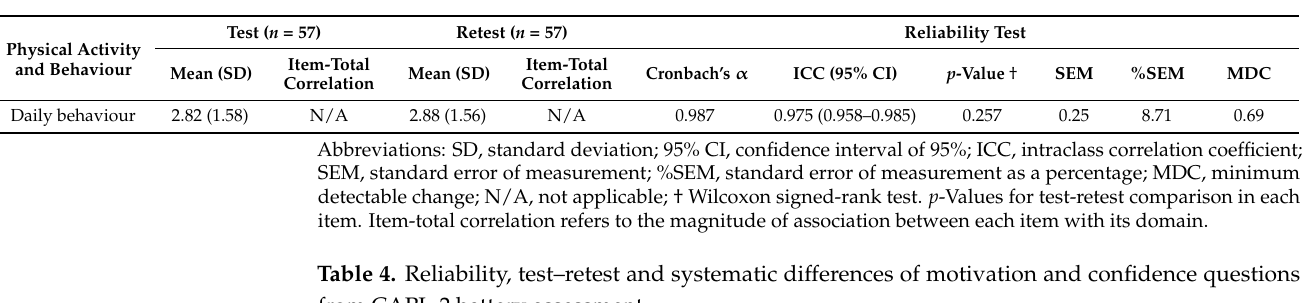
Table 3. Reliability, test–retest and systematic differences of auto-reported physical activity question from CAPL-2 battery assessment.